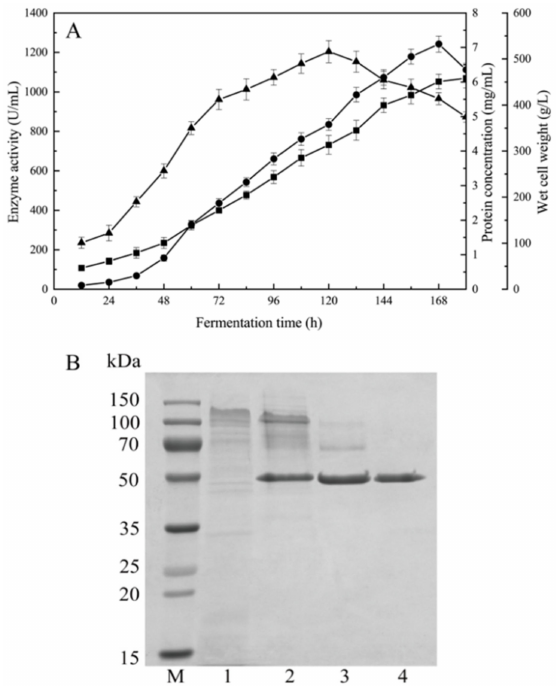
Figure 2. Time-course of RmproB produced by A. niger in 5 L fermentor ( A ) and SDS-PAGE analysis of the purified RmproB ( B ). Symbols are enzyme activity ( • ), protein concentration ( (cid:4) ), and wet cell weight ( (cid:78) ) of high-density fermentation ( A ). Lane M, protein molecular weight marker; lane 1, A. niger FBL-A for control; lane 2, the crude supernatant; lane 3, RmproB after QSFF; lane 4, RmproB after S-100 ( B